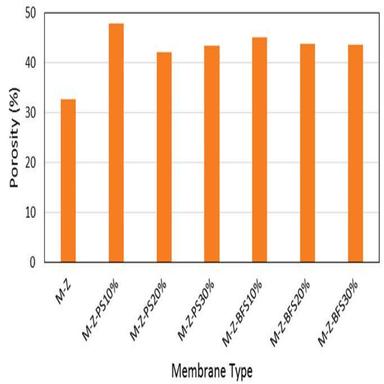
Porosity of sintered and alkali activated membranes.